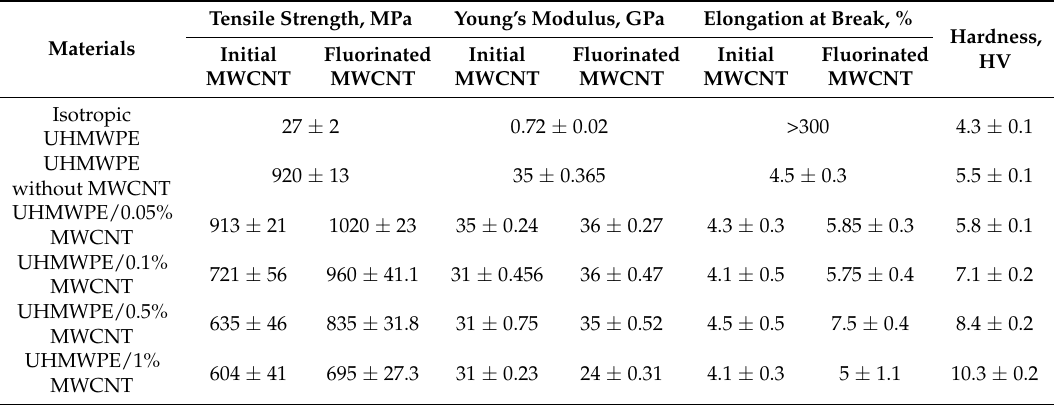
Table 2. Mechanical properties of films based on UHMWPE and initial/fluorinated MWCNTs with a DR of